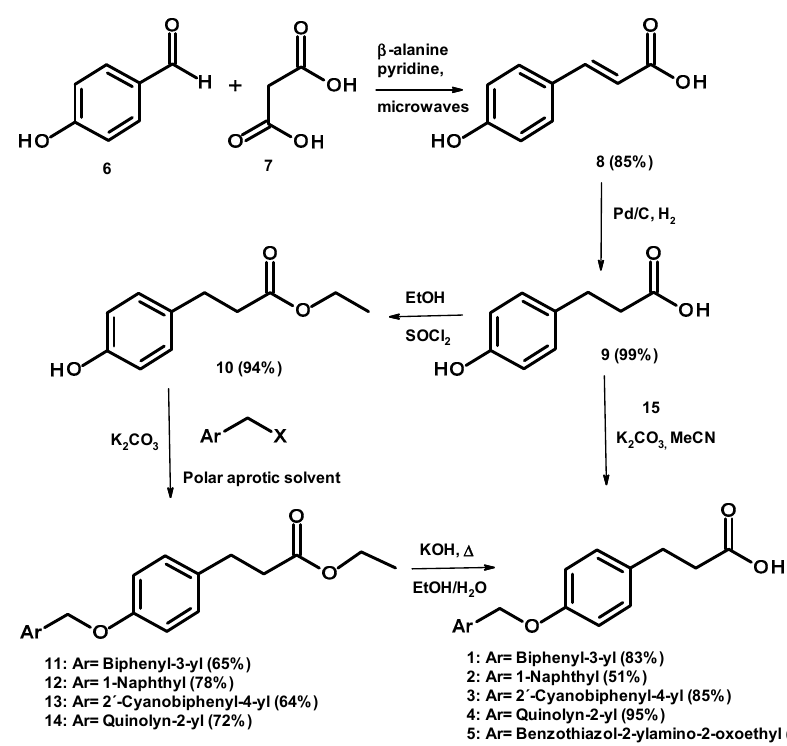
Scheme 1. Synthesis of compounds 1 – 5 .